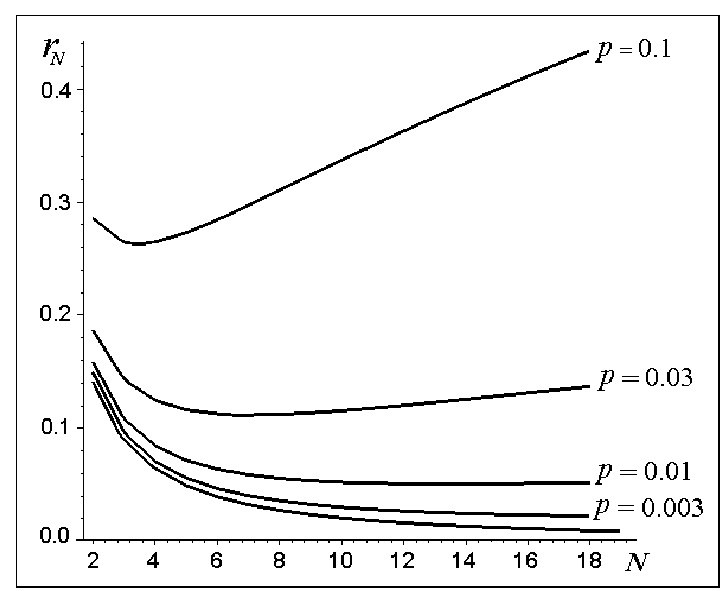
Figure 3. Graphs of functions of total errors N r . The lower curve corresponds to the rootmean-square error ~ (cid:101) R N . From the bottom up are the curves corresponding to the errors of the device p = 0.003, 0.01, 0.03, 0.1.